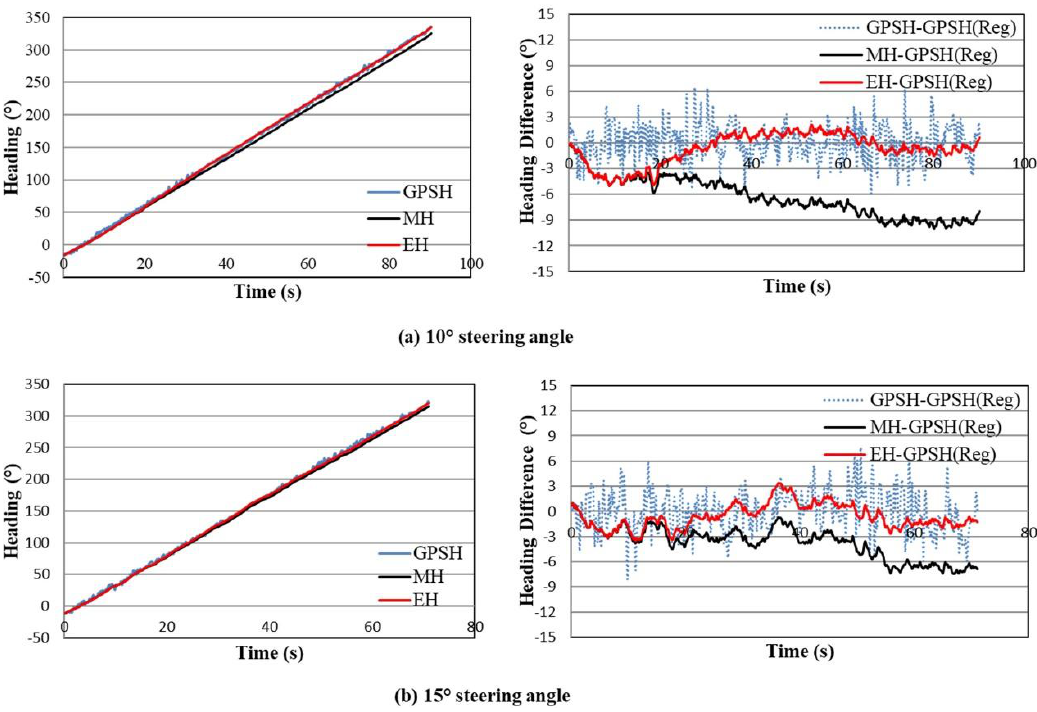
Figure 6. Measured and estimated headings (left figures) for circular trajectories as well as heading difference (right figures) (where, GPSH = GPS Heading, MH = Measured Heading, EH = Estimated Heading and GPSH (Reg) = Linear Regression of GPS Heading).